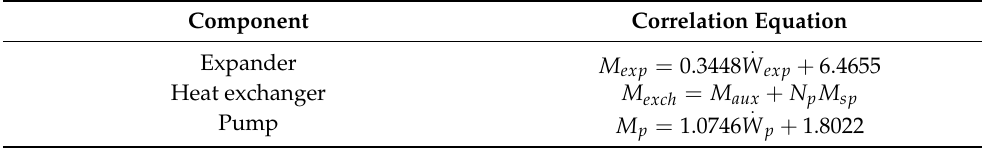
Table 9. The mass correlations of the main ORC